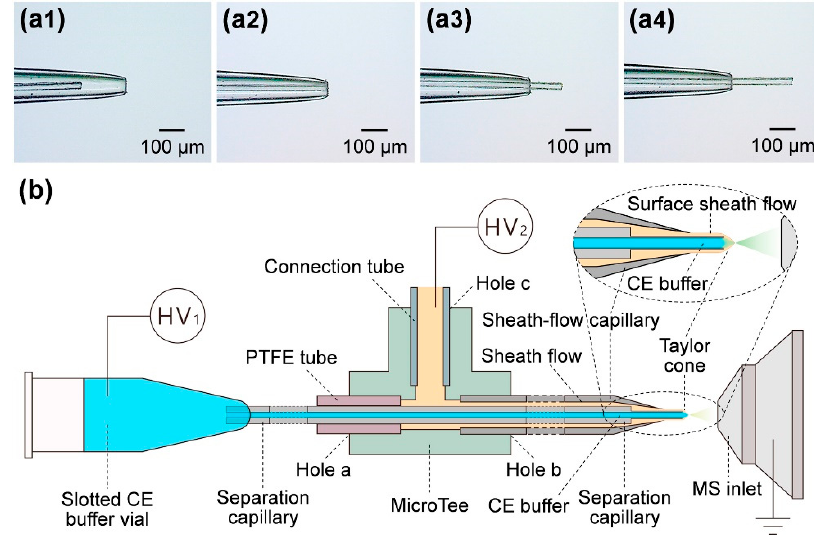
Figure 5. ( a1 – 4 ) Multiple positions of the capillary tip were evaluated to optimize the interface. ( b ) A detailed schematic of the interface developed by Fang et al. Sheath buffer is supplied from a coaxial capillary and flows into the emitter tip surrounding the separation capillary. The sheath buffer flows around the outlet of the separation capillary that is extended past the emitter tip to generate the Taylor cone in the presence of an electric field. This ensures efficient and steady ionization of analytes with minimal dead volume. Reprinted with permission [33]. Copyright 2018 American Chemical Society.